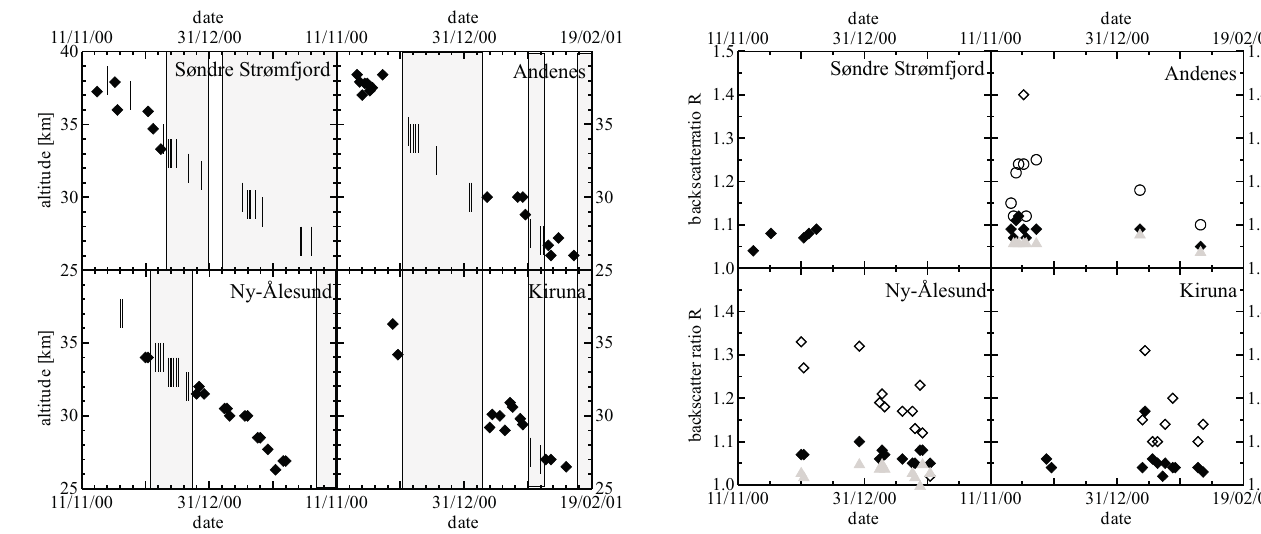
Fig. 4. Maximum backscatter ratio of the aerosol layer above the different stations, based on daily averaged data. Wavelength and polarisation are signed by marker style: 353/355nm: grey triangles; 532nm non-polarised/parallel polarised: filled diamonds; 532nm perpendicular polarised: open diamonds; 1064nm: open